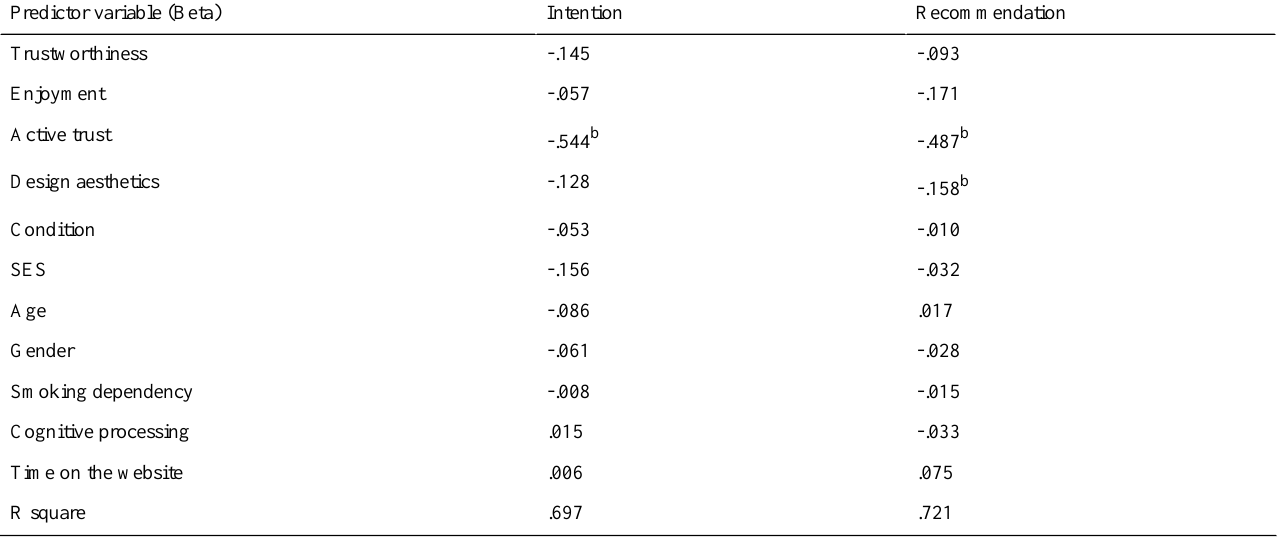
Table 7. Multiple regression analysis for future adherence